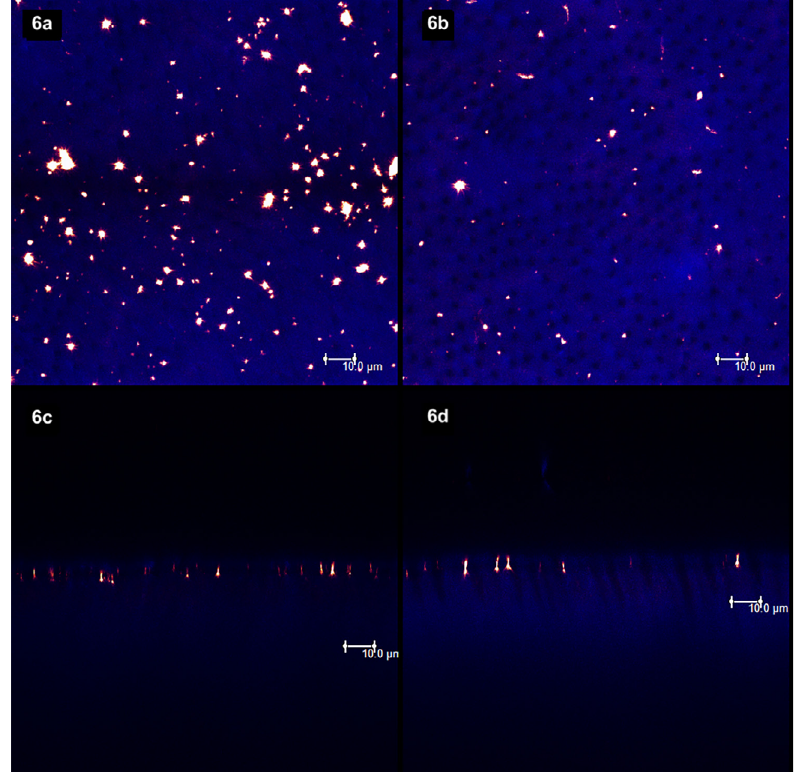
Figure 6- The 20 wt.% S-PRG-based toothpaste promoted some solid deposits on the dentin surface (6a) and at the dentinal tubules (6c). Yet, the number of particles on the surface (6b) and at the aperture of the tubules (6d) decreased significantly after the erosive challenge